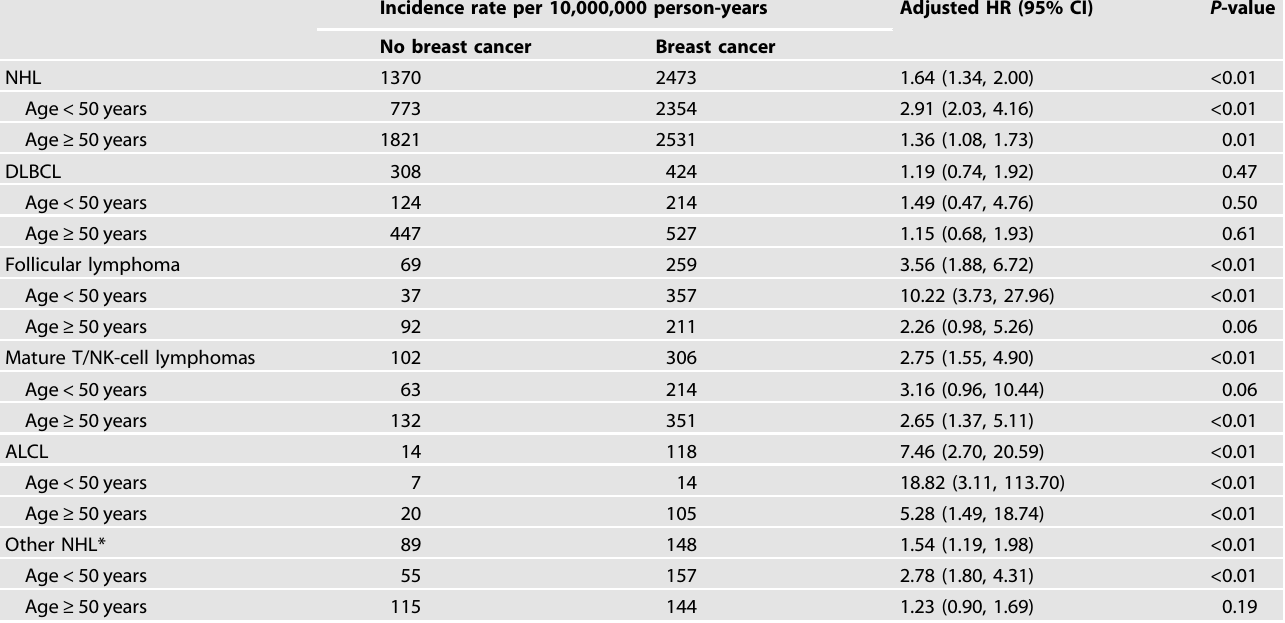
Table 2. Hazard ratios (95% CI) for incident NHL associated with incident breast cancer.